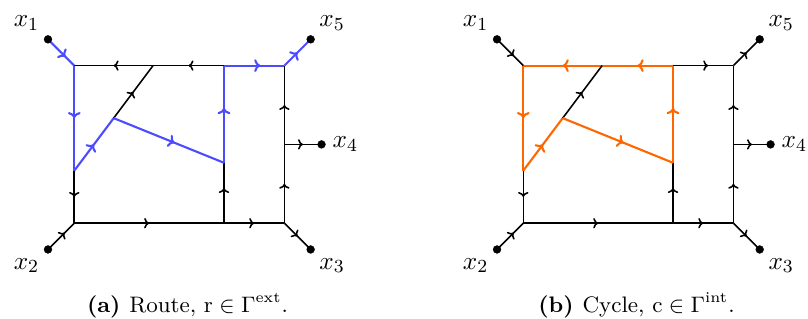
Figure 2. Admissible paths of different types through a digraph ( G, σ ) : a route and a cycle. The illustrated graph has in-going external vertices V ext = { 3 , 4 , 5 } . The route r connects the in-going vertex 1 to the out-going vertex 5 . Hence, V ext out i ( r ) = 1 and f ( r ) = 5